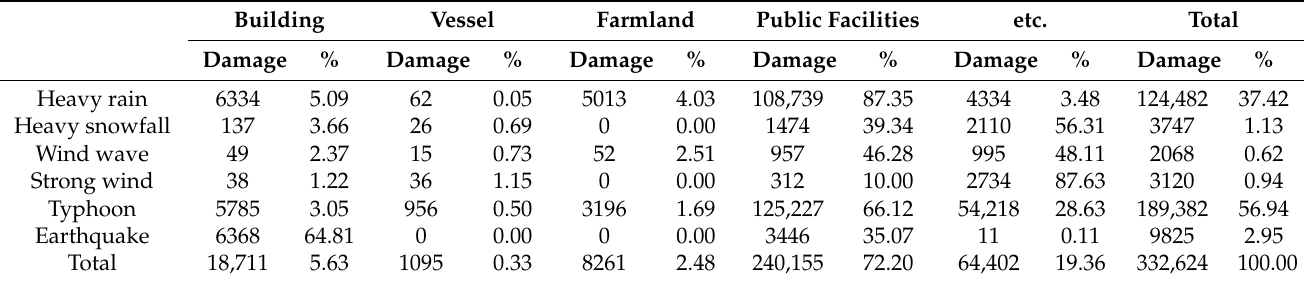
Table 1. Damage caused and facilities by natural disasters (2010–2019) in Korea [21].